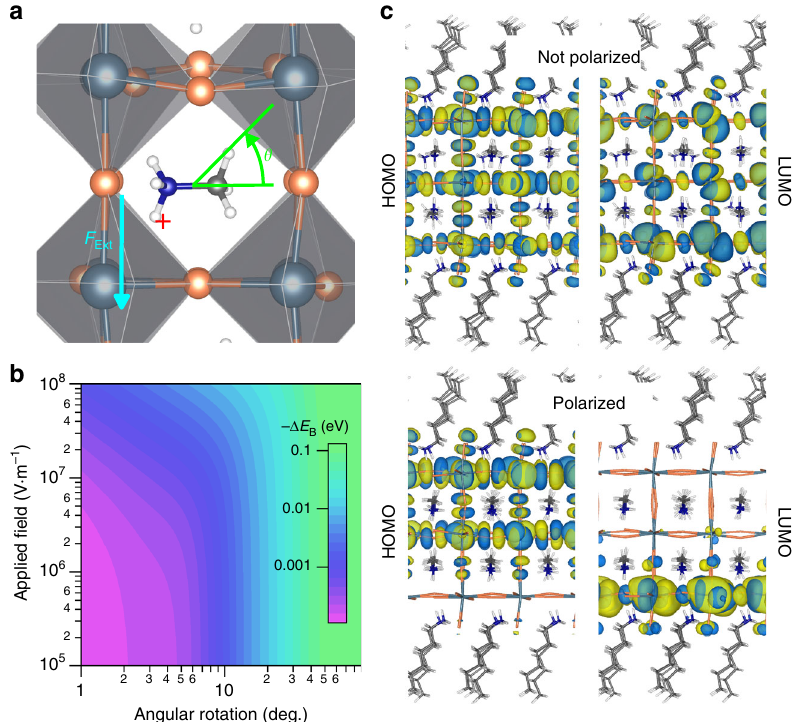
Fig. 4 Methylammonium in fl uence on changes in the exciton binding energy. a Rotation, as de fi ned by θ , of methylammonium cations away from the effective neutral position within a perovskite well when torqued by an external electric fi eld, F Ext . A single perovskite unit cell is shown (window size 9.8 × 9.8 Å). b Calculated change in exciton binding energy using DFT-calculated wavefunctions as a function of net methylammonium rotation and applied electric fi eld for an n = 3 methylammonium-layered perovskite. c DFT-calculated spatial reorganization of frontier orbitals in a single n = 3 layered perovskite (layer thickness = 34 Å) with unpolarized and polarized methylammonium cations. An electric fi eld of 20 kV cm − 1 has been applied. The frontier molecular orbitals are shown as isosurfaces (at 0.0046 a.u.) with positive and negative regions of the wavefunctions shown in yellow and blue,